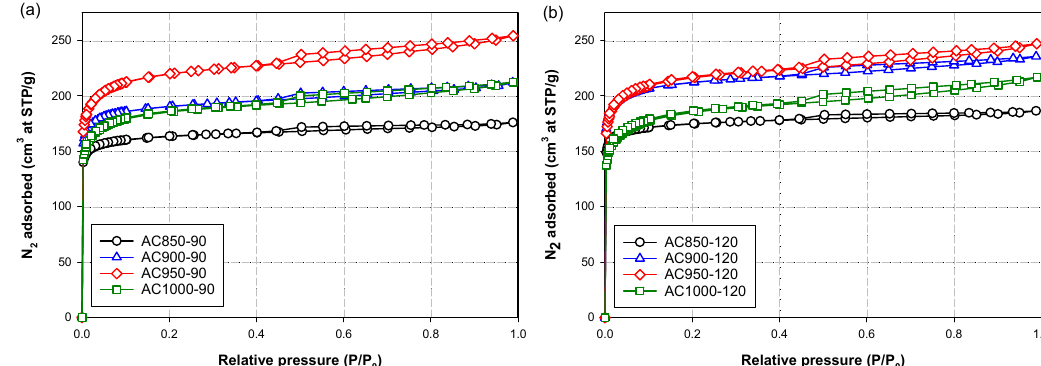
Figure 3. Effects of activation temperature and activation time on N 2 adsorption isotherms of activated carbon prepared by CO 2 activation at ( a ) 850 to 1000 ◦ C and 90 min ( b ) 850 to 1000 ◦ C and 120 min. The activated carbons were derived from char carbonized at 500 ◦ C and 90 min .